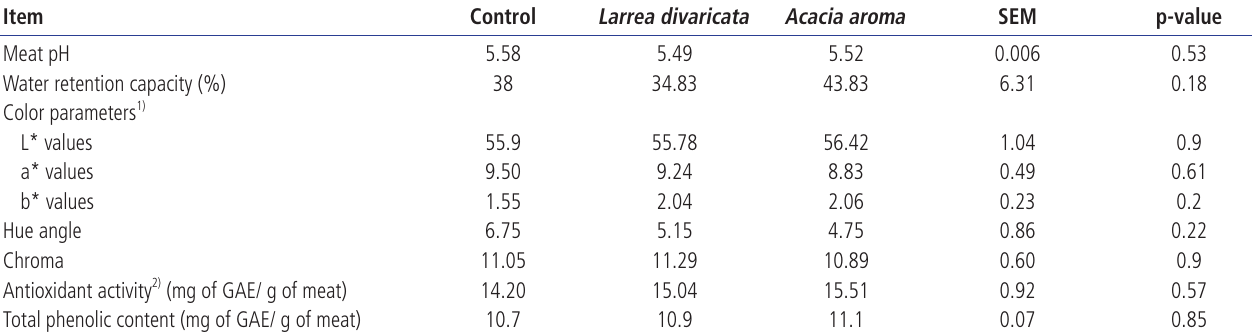
Table 3. Effect of the dietary tannin-rich leaves on meat quality of feeding goats Item Control Larrea divaricata Acacia